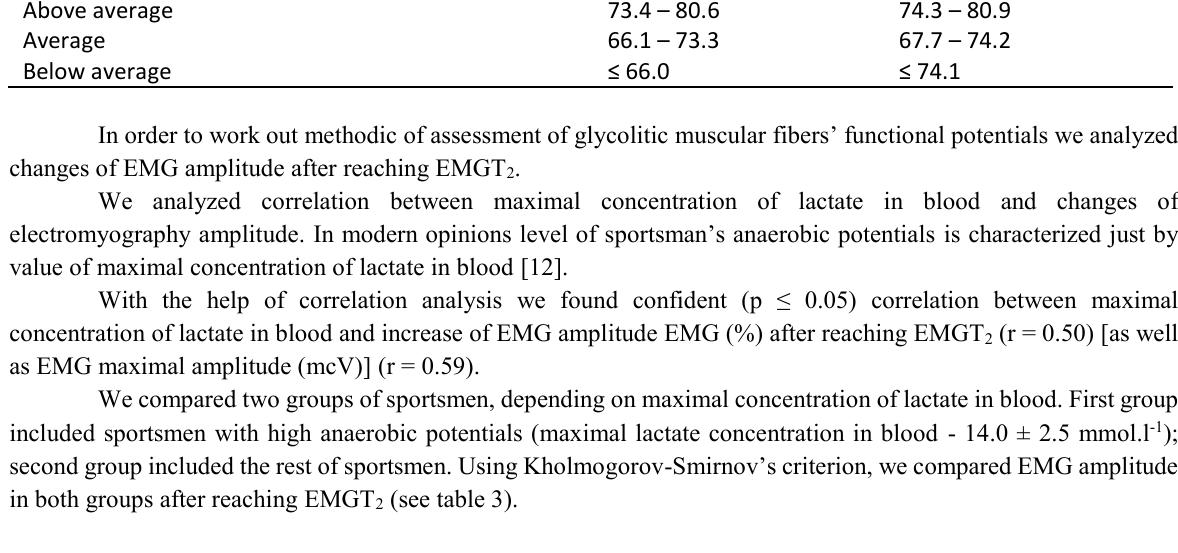
Table 3. Values VO 2, W, EMG amplitudes (Аmax) and EMG amplitudes’ increment after reaching EMGT 2 (∆А) in sportsmen with different anaerobic potentials (n = 18,